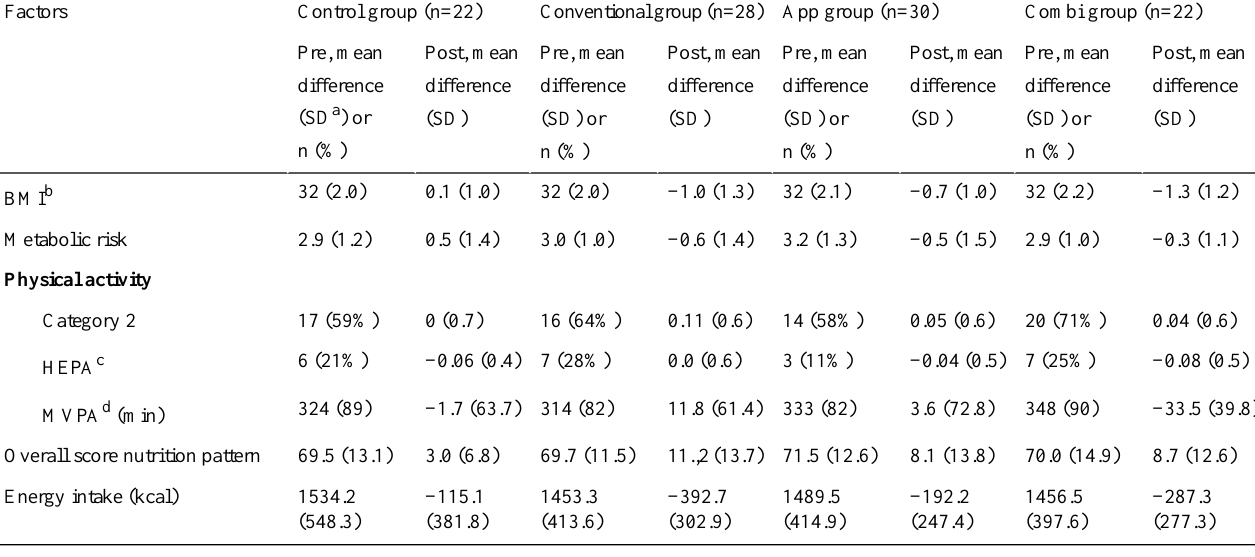
Table 2. Changes in body mass index (BMI), metabolic risk factors, physical activity, and dietary